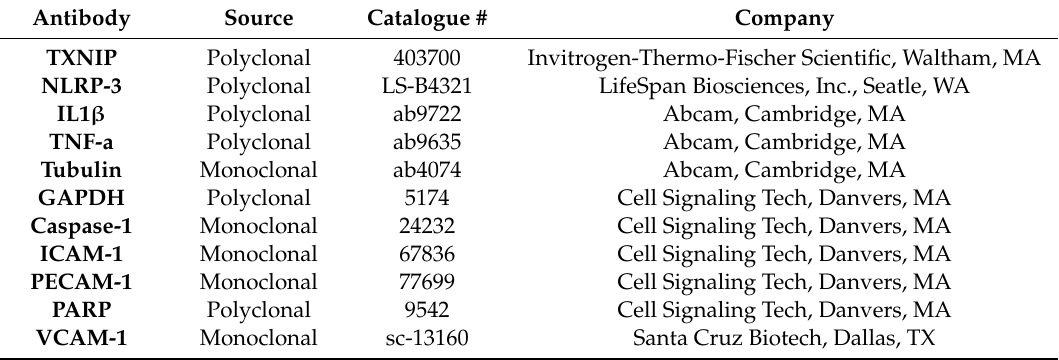
Table 2. List of antibodies and sources used to detect protein expression by Western blot. All antibodies were obtained commercially and validated by its